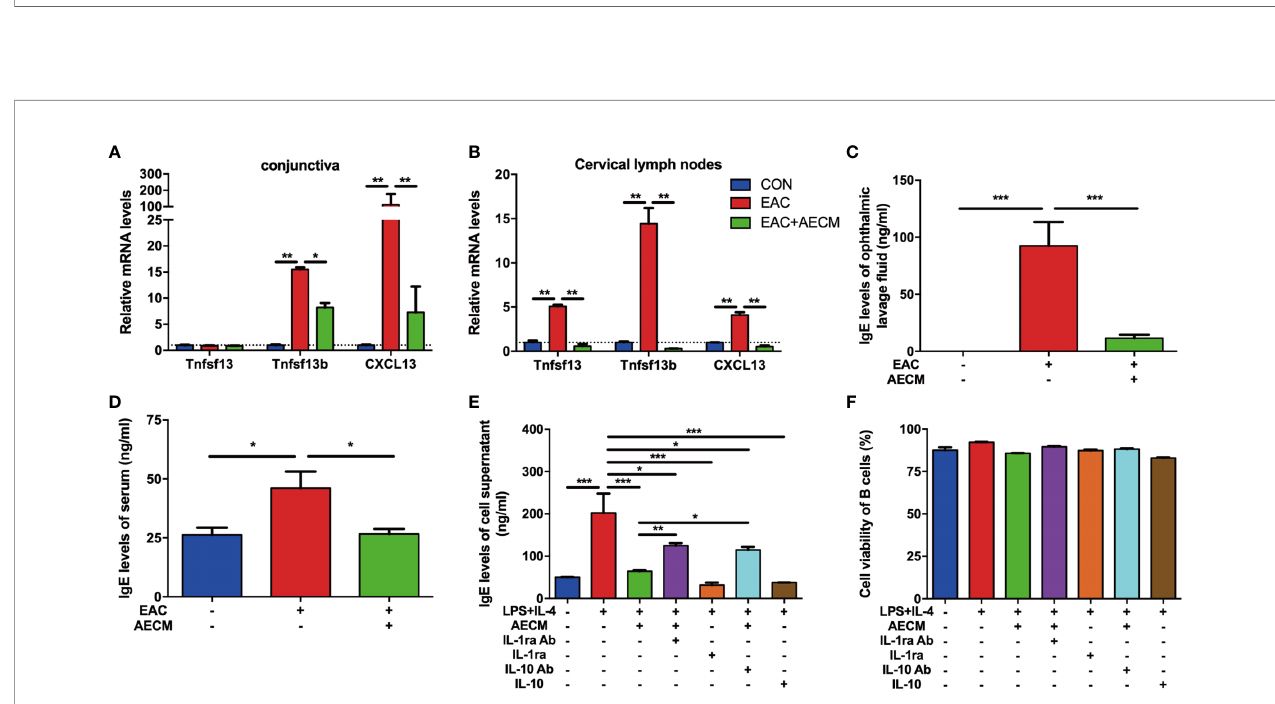
FIGURE 4 | AECM inhibited IgE release by B cells. (A, B) Real-time PCR analysis of mRNA levels of marker genes of B cells in conjunctiva (A) and cervical lymph nodes (B) of mice in each group. The expression levels of genes in CON group were set as 1, and the data are expressed as the mean ± SEM, n = 3. (C, D) IgE levels in the ophthalmic lavage fl uid (C) and serum (D) of mice in each group. The data are expressed as the mean ± SEM, n = 3. (E) IgE levels in the supernatant of puri fi ed B cells activated by IL-4 (50 ng/ml) plus LPS (10 mg/ml) for 5 days in each group. Data were collected from at least three separate experiments, and the data are expressed as the mean ± SEM. (F) The cell viability of puri fi ed B cells was assayed by trypan blue exclusion. * P < 0.05, ** P < 0.01, and *** P <